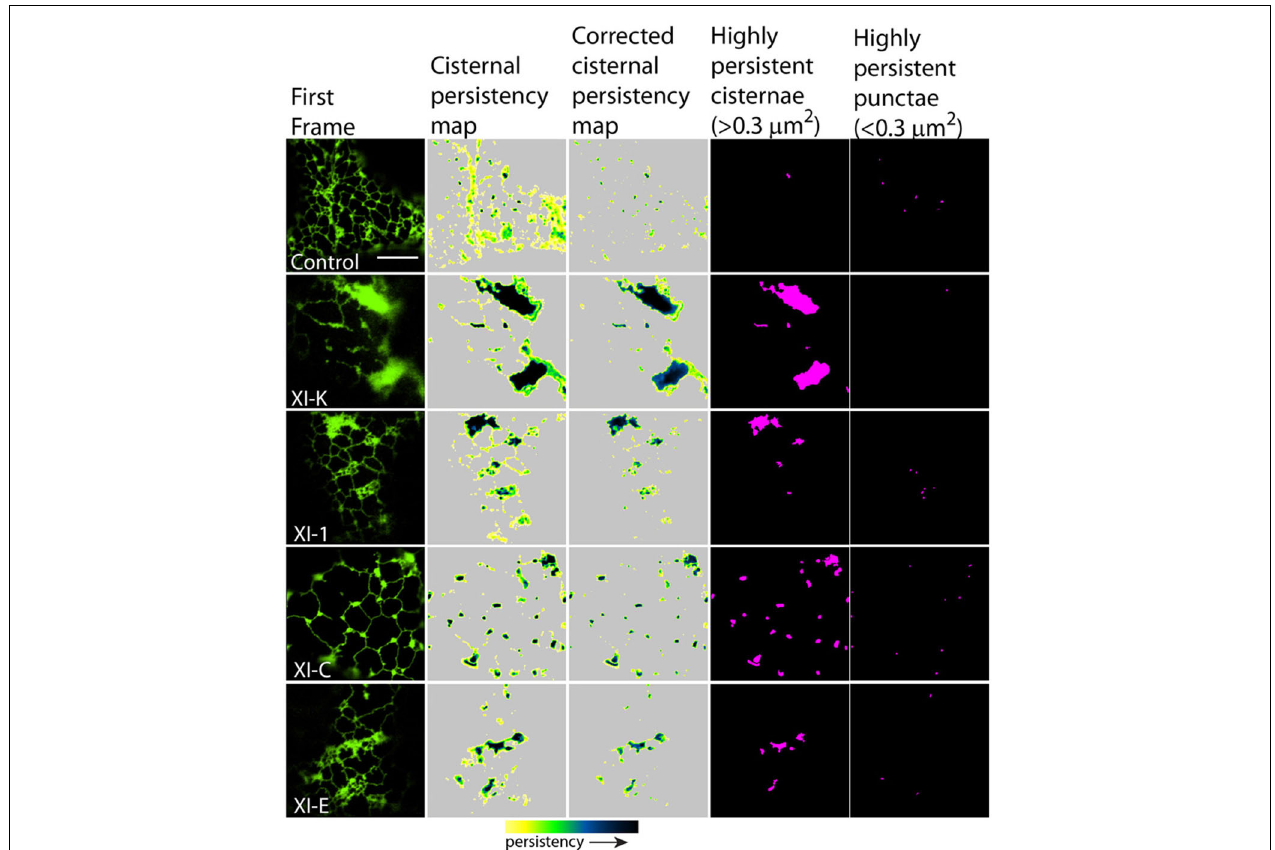
FIGURE 5 | Effects of XI-K, XI-C, XI-E, and XI-1 myosin tail domains on persistent ER cisternae and punctae identified with co-expressed GFP-HDEL. Left-hand panel is the first frame of a 50 frame movie. Middle two panels are cisternal persistency expressed as the sum of cisternae (morphometrically separated from tubules with a binary opening operation) that persist for at least five frames (7.9s). The corrected cisternal persistency subtracts out regions of continuous flow (sum of five frame differences). The